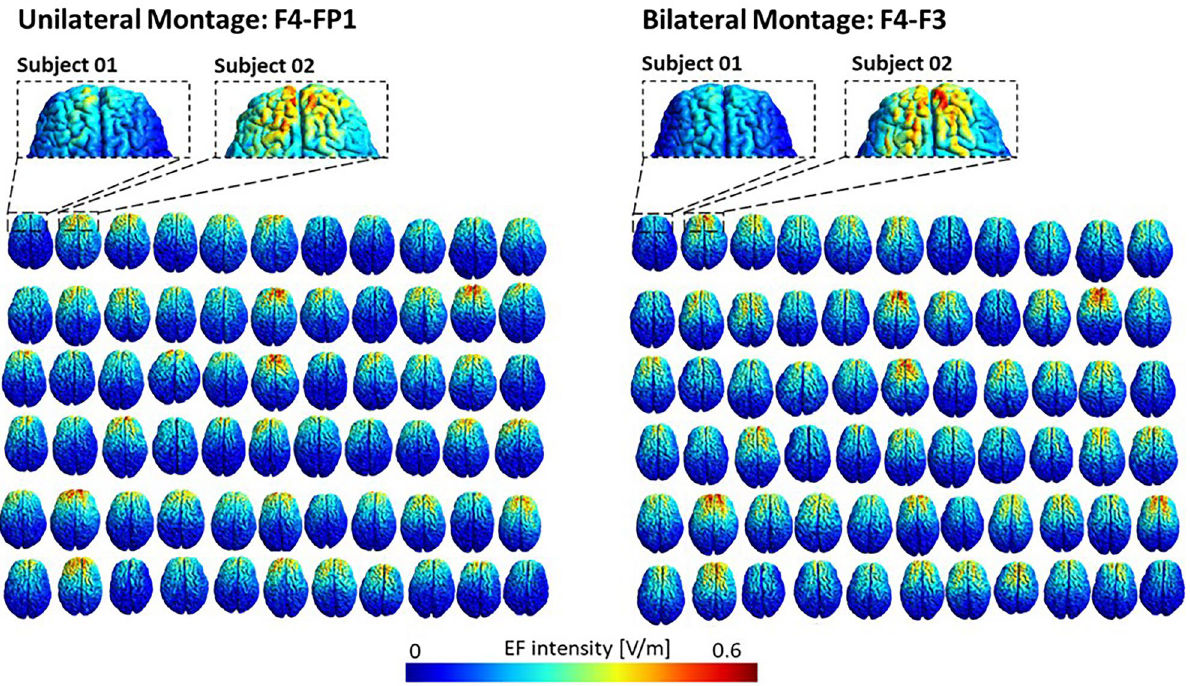
Figure 2. Individualized computational head models: Electric field distribution patterns of 66 participants for DLPFC stimulation with the anode over F4, cathode over the supraorbital area (F4–Fp1 montage) for unilateral montage and anode over F4, cathode over F3 for bilateral montage in subject native space. A current of 2 mA is used in the stimulation.